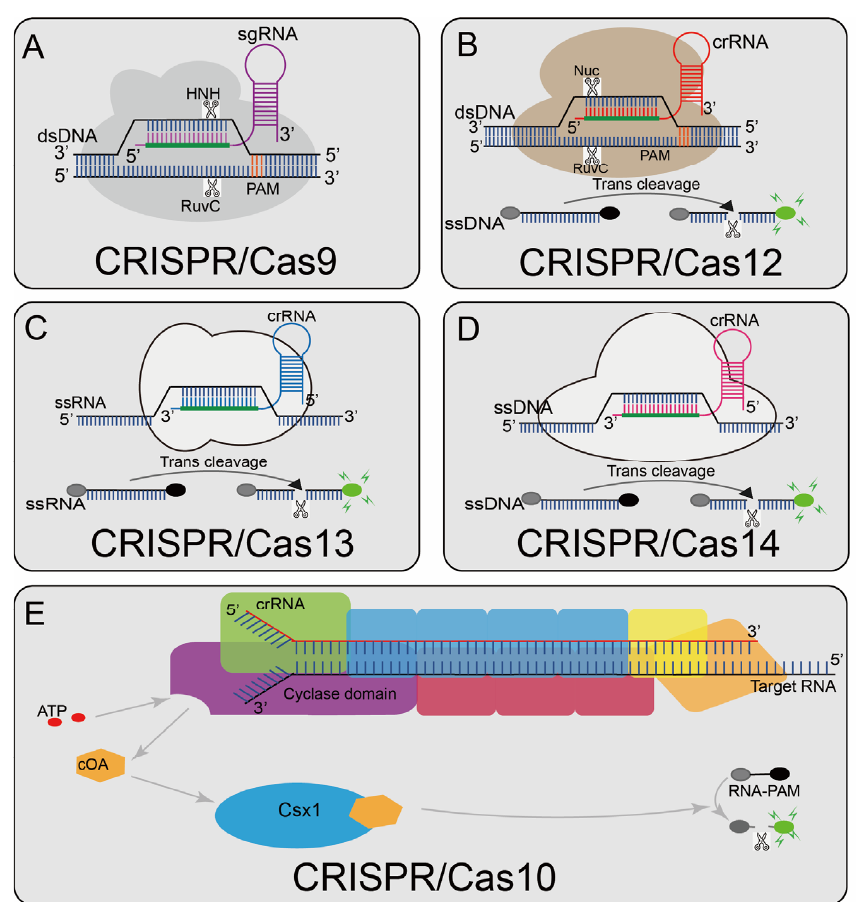
Figure 1. Overview of CRISPR-Cas enzyme activities and their catalytic mechanisms ( A ) Cas9 can cleave the target and non-target strands of DNA; a short trinucleotide PAM is also essential for the initial DNA binding; ( B ) Cas12a can cleave dsDNA under the guidance of gRNA. The Cas12a enzyme recognizes the PAM of the original T-rich spacer and then recognizes the target sequence to generate PAM distal dsDNA breaks with staggered 5 ′ and 3 ′ ends, and Cas12 has the side chains trans-cleavage activity. At the time that the sgRNA-guided DNA is combined in Cas12, Cas12 will release a powerful, indiscriminate single-stranded DNA (ssDNA) cleavage activity; ( C ): Cas13 can activate its single-stranded RNA (ssRNA) cleavage activity by binding to crRNA, and it has a additional cleavage activity triggered by the target RNA; ( D ) Cas14 protein is a RNA-guided nuclease and can recognize the target ssDNA without restriction sequences and cleave it, and also can non- specifically cleave the surrounding ssDNA nucleases molecule; ( E ) Cas10 is a multi-component and multi-pronged immune effector that can be activated by viral RNA, and the viral RNA will activate Cas10 polymerization enzymes that produce about 1000 cyclic nucleotides (cOA). cOA activates Csx1, cutting off the fluorophore connected to the